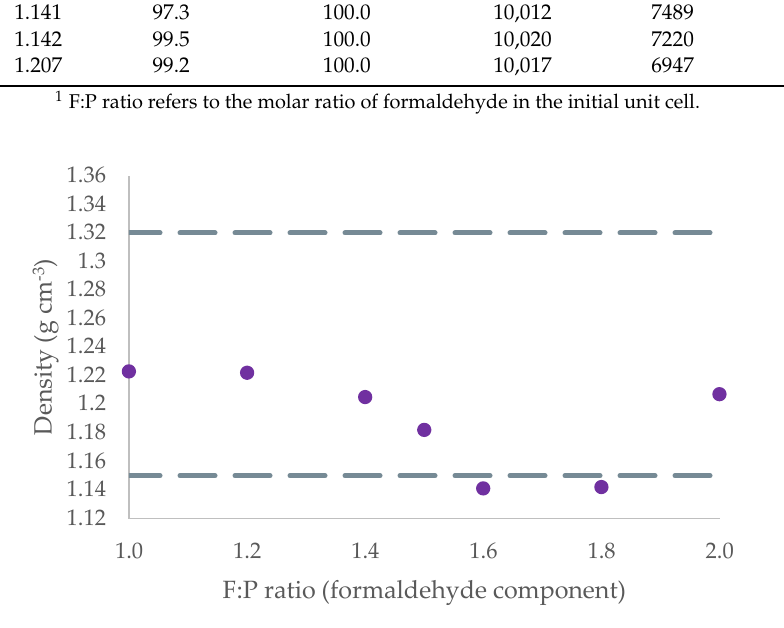
Figure 5. Graphical representation of density as a function of F:P ratio for cured 10,000 atom structures. Grey dashed lines indicate the upper and lower bound densities found within the literature [17,42].